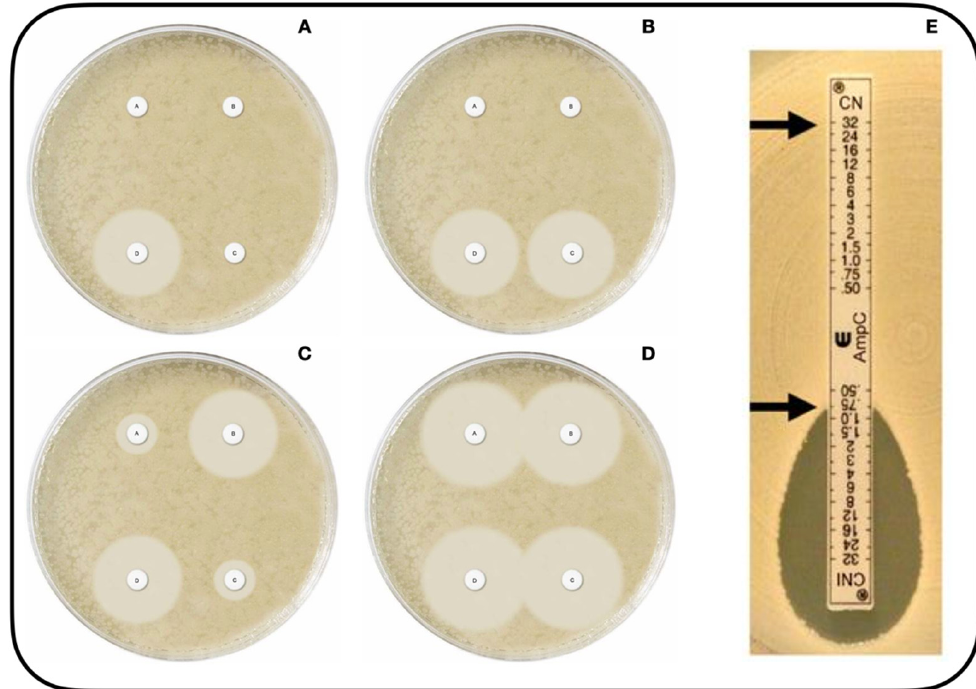
Figure 1. Phenotypic methods of AMPc beta-lactamase detection (Available online: https://mast- group.com/uk/products/amr/antibiotic-resistance-detection-sets/d68c/ (accessed on 25 October 2021). Mast Disk test, with four disks [123]: Disk A(Cefpodoxime), disk B